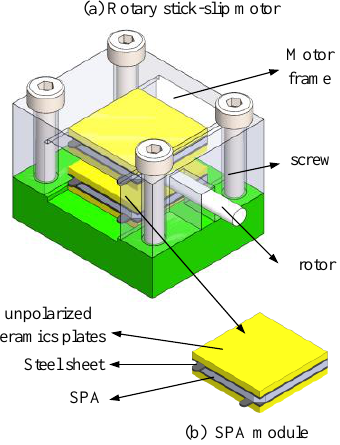
Figure 1. ( a ) Schematic view of the rotary stick – slip motor; ( b ) The SPA module.